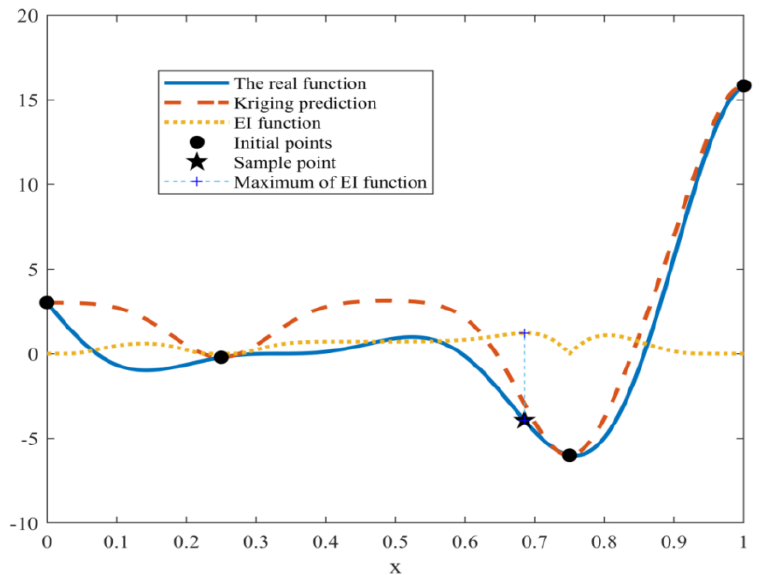
Figure 1. Maximizing the EI function to obtain the new sampling point (the example is based on the Forrester function [25]).